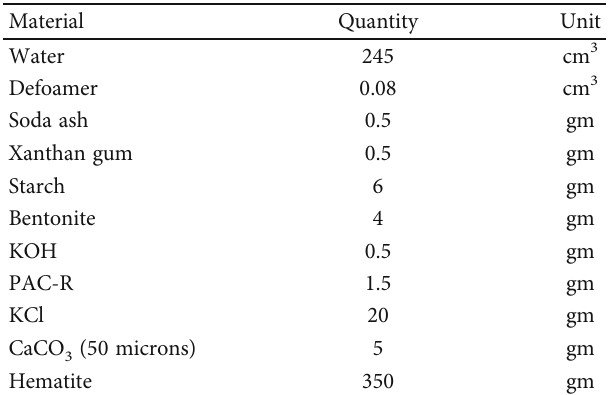
Table 1: Drilling fl uid